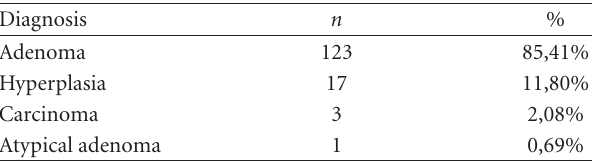
Table 1: Diagnoses in primary hyperthyroidism. Diagnosis n % Adenoma